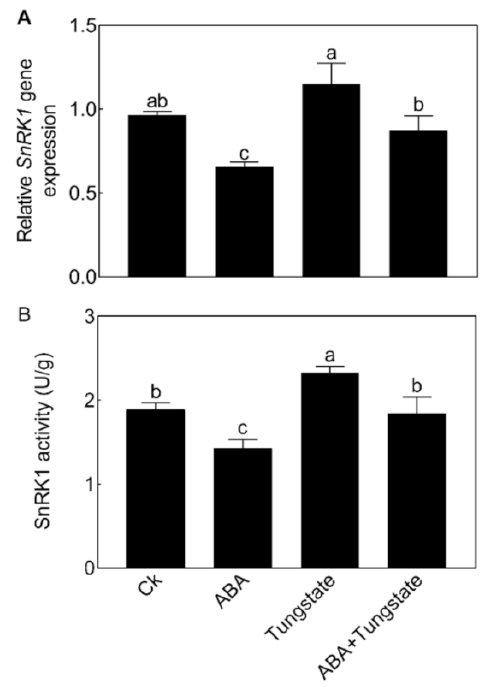
Figure 8. Effects of abscisic acid (ABA) and tungstate treatments on the lotus. Two-month-old lotus seedlings were treated with 80 µ M ABA and 4.5 mM tungstate. After 9 days of treatment, the expression level ( A ) and activity ( B ) of NnSnRK1 in the flower buds were analyzed. Values are the means ± SE of three independent experiments with at least three replicates for each. Bars marked with different letters are significantly different from each other at p < 0.05, according to Tukey’s multiple